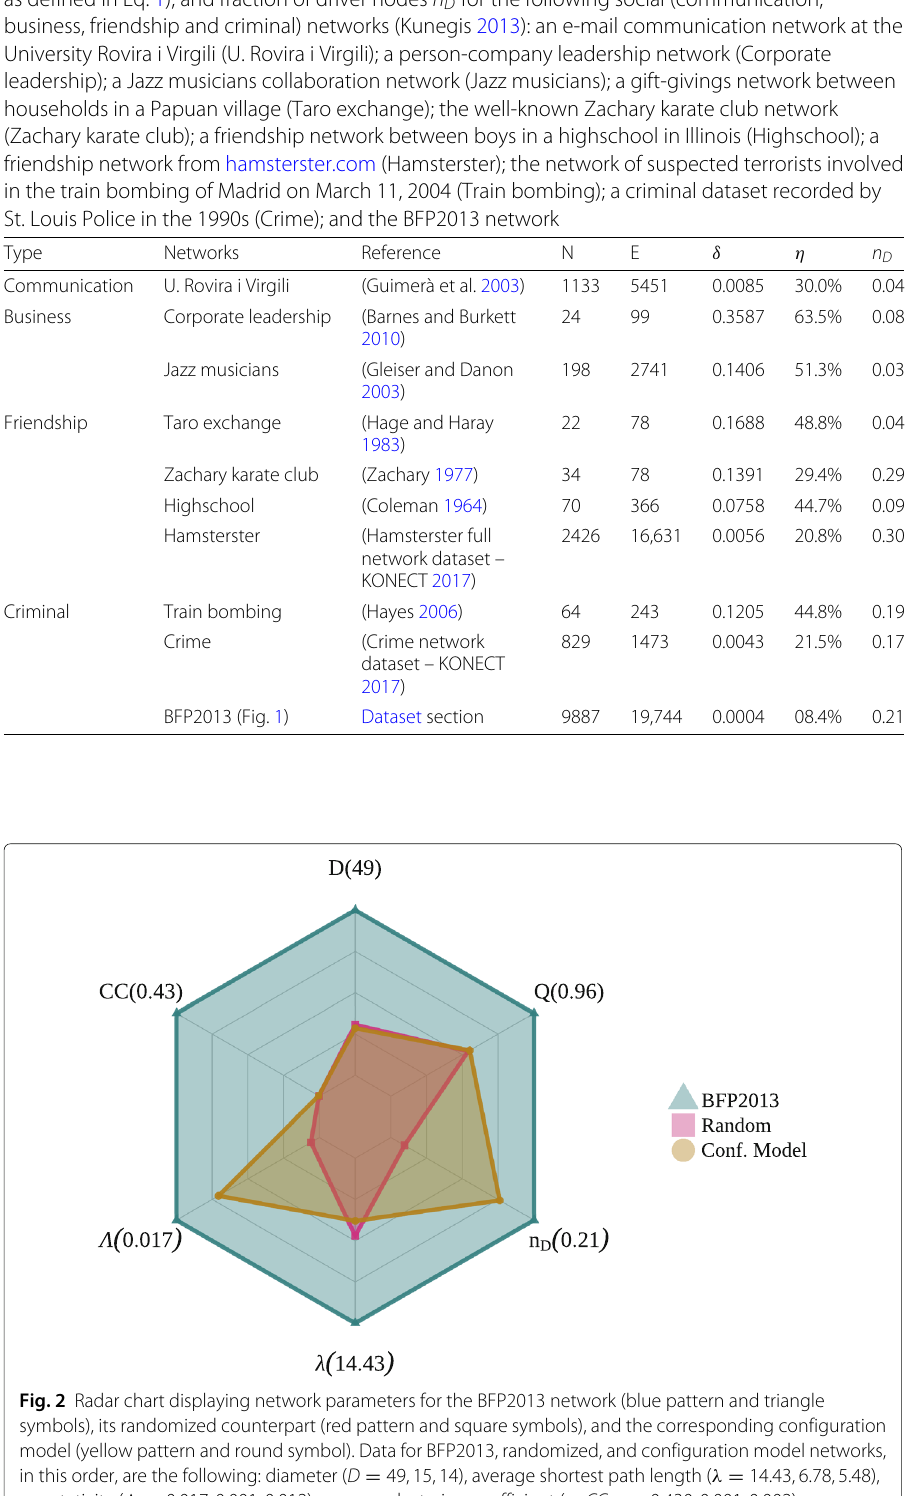
Table 1 Comparative data between the federal criminal intelligence network and other social networks: number of nodes ( N ), number of edges ( E ), edge density ( δ =2E/N(N-1)), graph efficiency ( η as defined in Eq. 1), and fraction of driver nodes n D for the following social (communication,